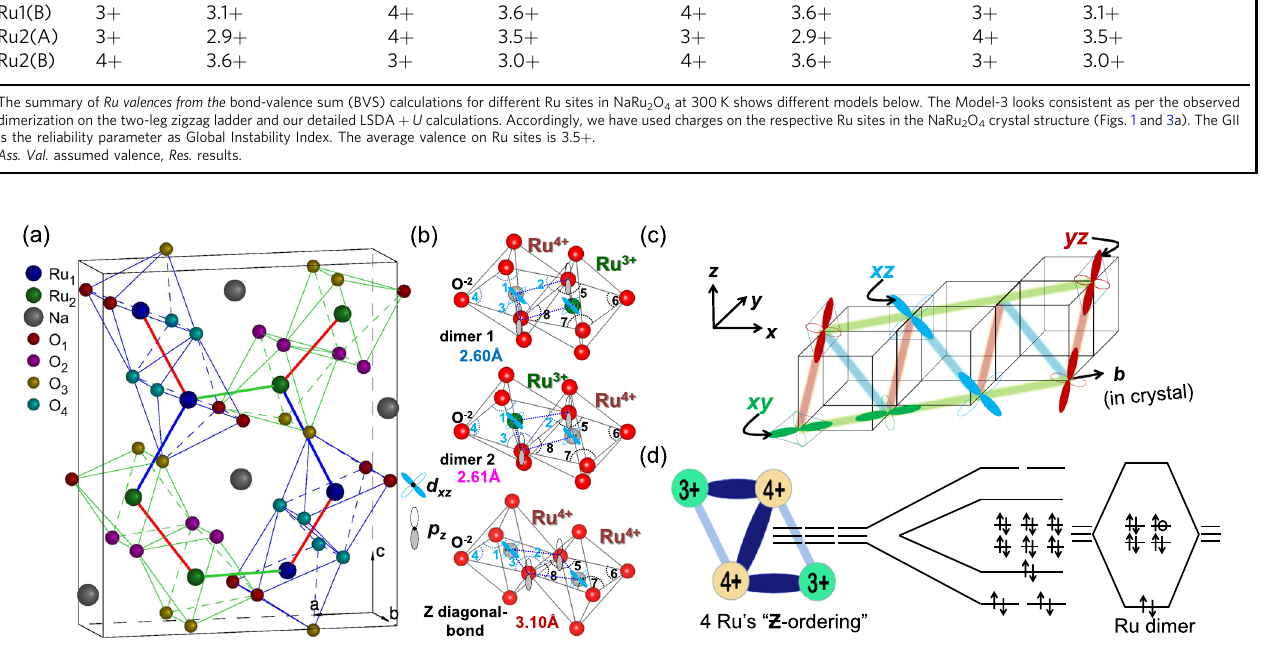
Fig. 9 CaFe 2 O 4 -type tunnel structure and edge-sharing RuO 6 two-leg ladders in NaRu 2 O 4 lattice. a The orthorhombic Pnma crystal structure. b The bond between the two RuO 6 octahedra for each dimer 1 (2.60 Å), dimer 2 (2.61 Å), and Z diagonal-bond (3.10 Å). c Schematic representation of the double chain with two-leg zigzag ladders (solid thick light-green, reddish-brown, and sky-blue lines). d The two-leg zigzag ladders in two different forms, either corner- (blue or green ladders) or edge- (red ladders), sharing RuO 6